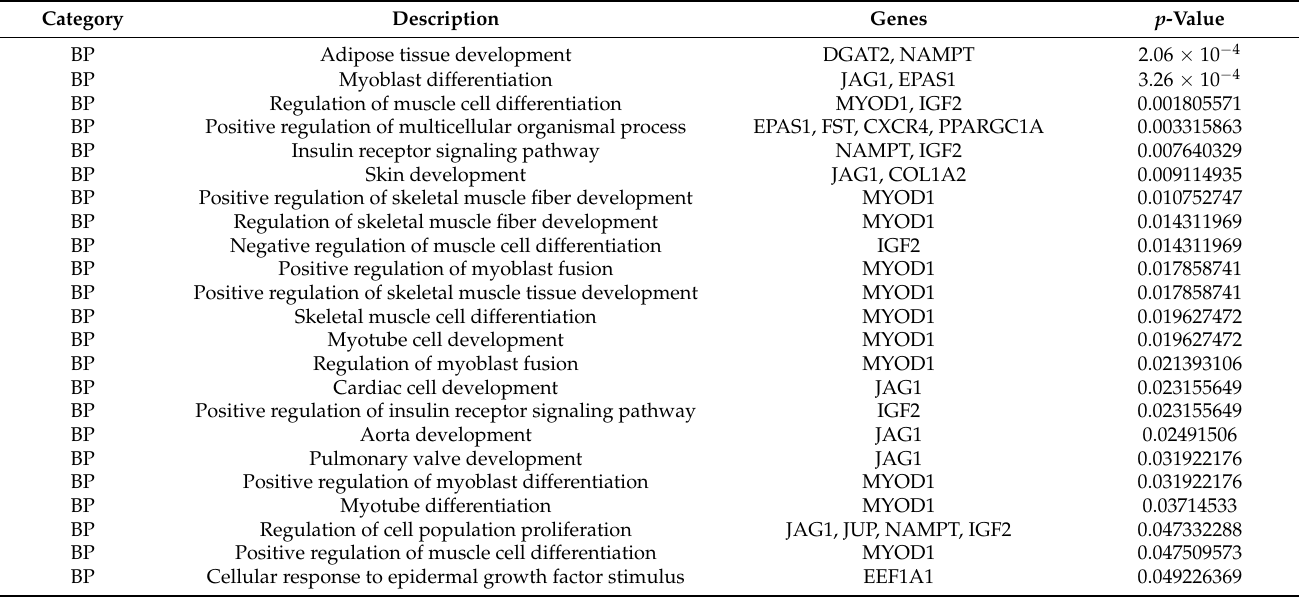
Table 6. Biological processes associated with skeletal-muscle-maturation- and hypertrophy-related DEGs common for Bos taurus, Ovis aries , and Sus scrofa